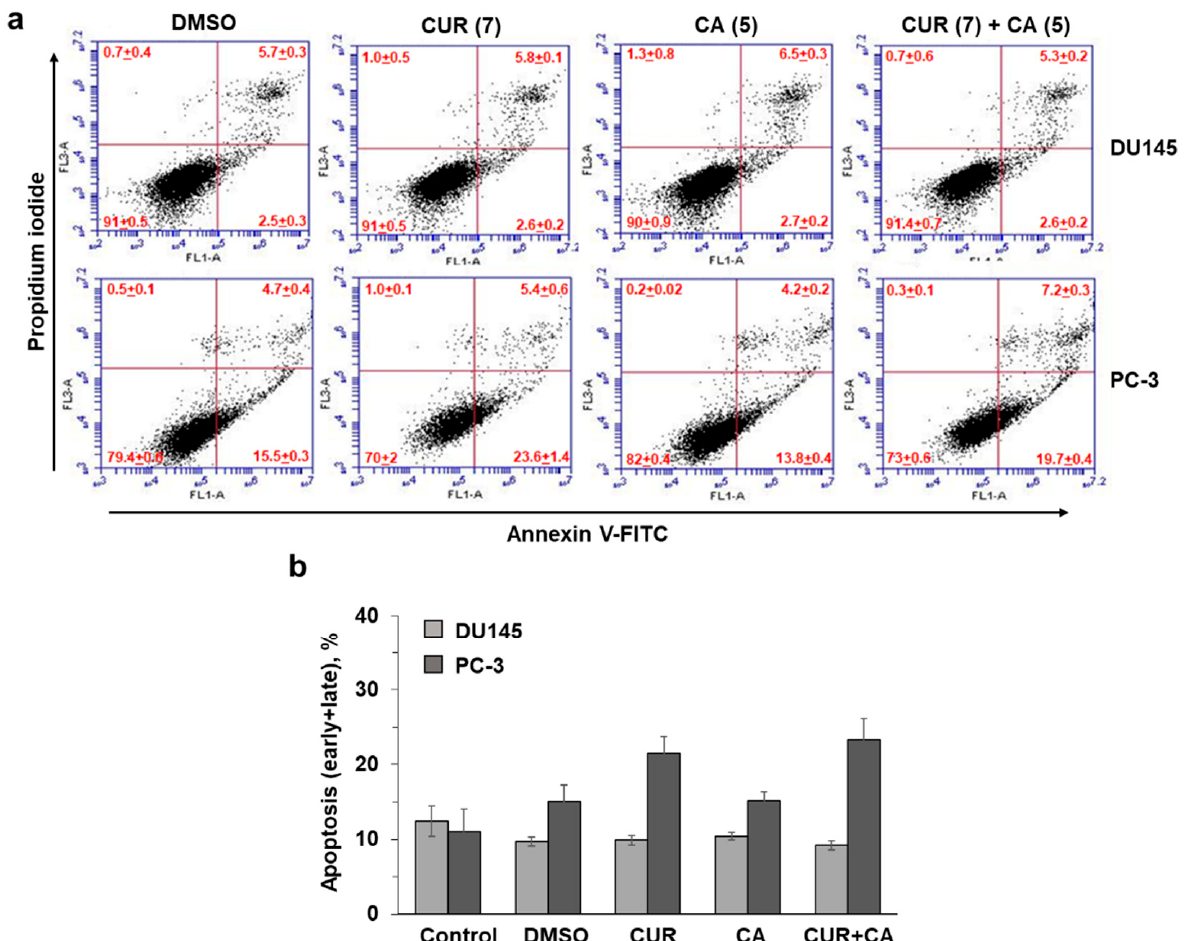
Figure 2. Effects of curcumin and carnosic acid on the induction of apoptosis. ( a ) Examples of primary flow cytometric data of annexin-V and propidium iodide binding to DU145 and PC-3 cells under the indicated treatment conditions (48 h). ( b ) Summarized data of apoptosis (early + late) induction, as exemplified in panel ( a ). Values given in parentheses are concentrations ( µ M). Data are presented as mean ± SEM ( n = 3).